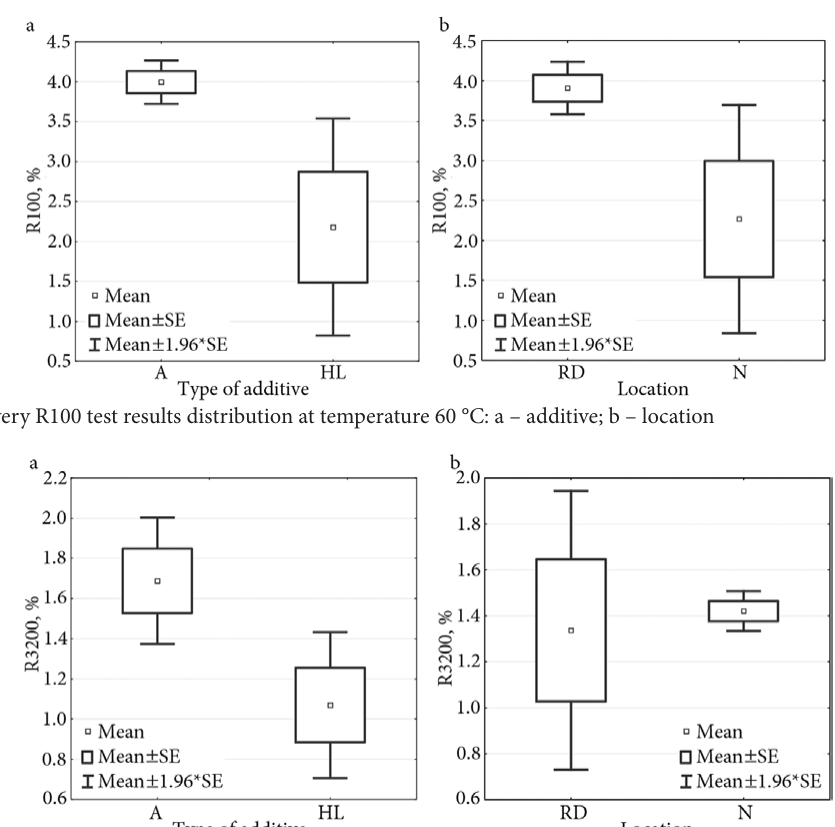
Fig. 11. Creep compliance (Jnr3200) test results distribution at temperature 60 °C: a – additive; b – location